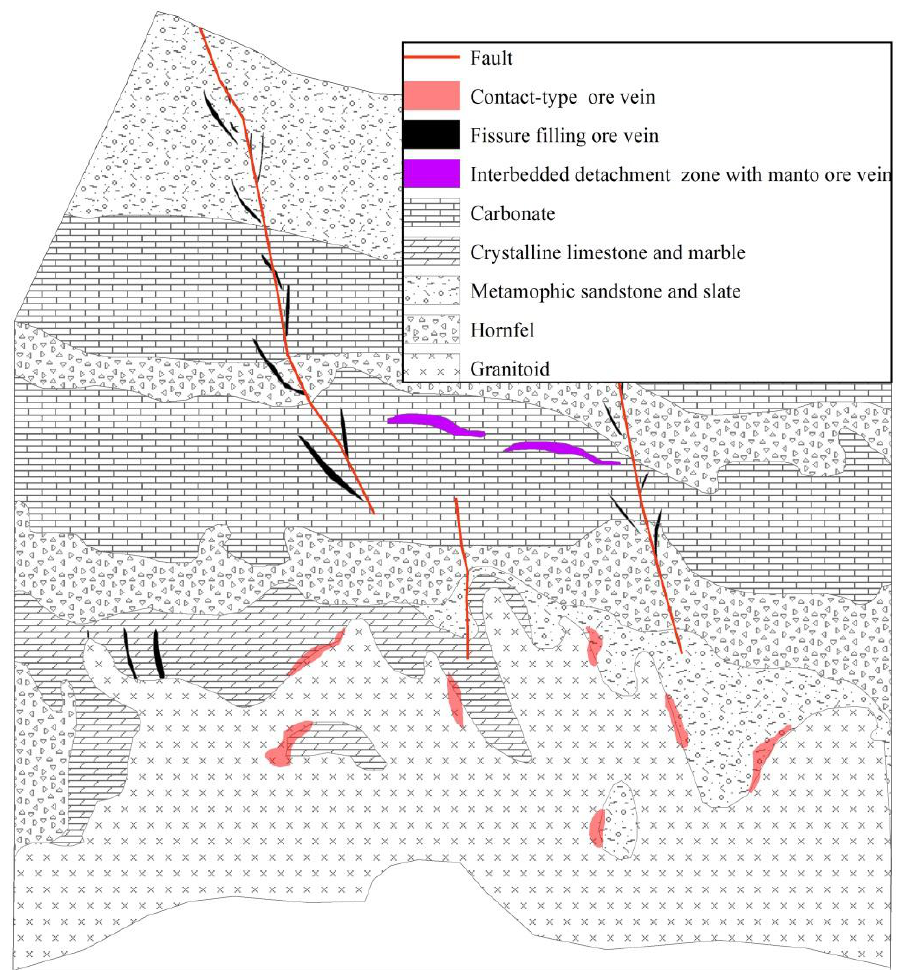
Fig. 2. Deposit model of the contact structural system of magma emplacement (modified after Pei et al., 419